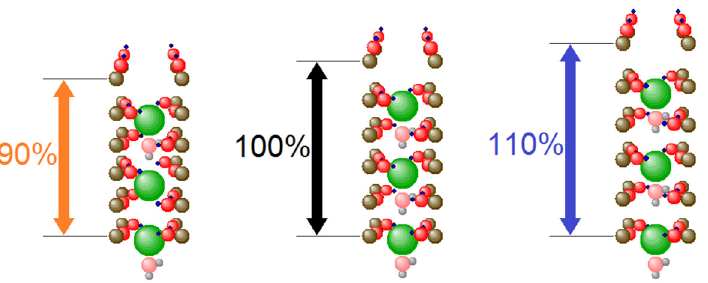
Figure 3. Changing the length of the selectivity filter. Simulations were made for different lengths, ranging from 92% to 110% of the ‘standard length’.